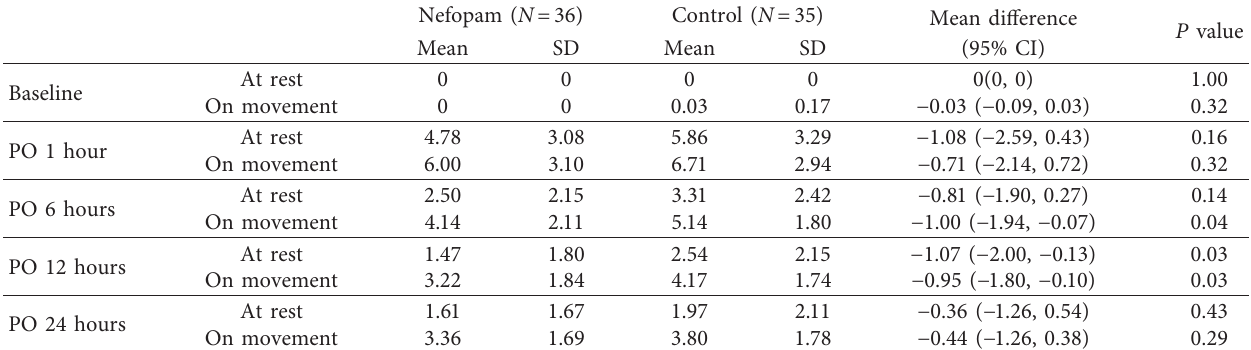
Table 5: Pain score assessment during the operation and after the